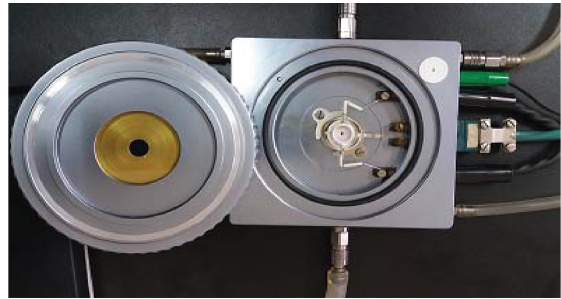
Figure 2: Thermo-stage